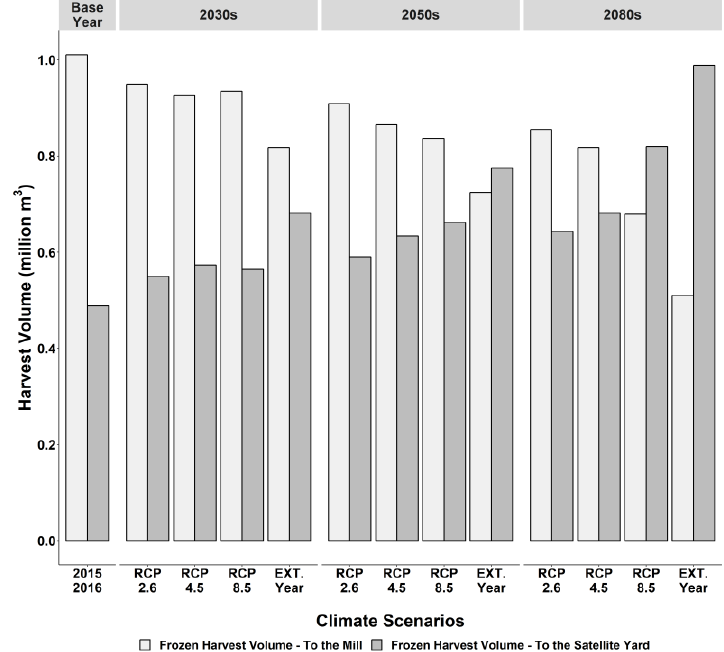
Figure 4. Use of satellite yard to distribute winter harvest volume of woods (m 3 ) with the criteria to minimize the total number of idle hauling trucks over the entire year under different climate scenarios at different time intervals.